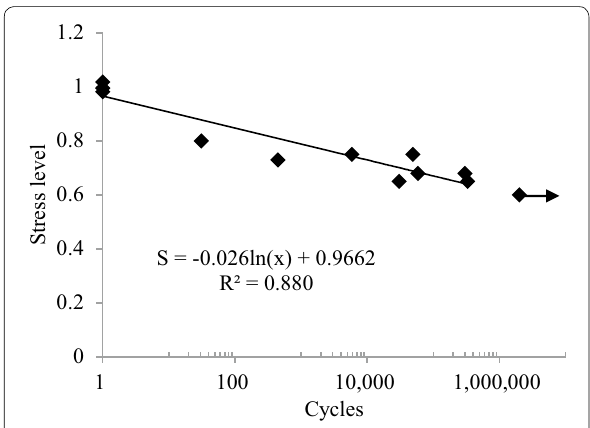
Fig. 14 Log-linear plot between the stress level and the fatigue life of BFRP